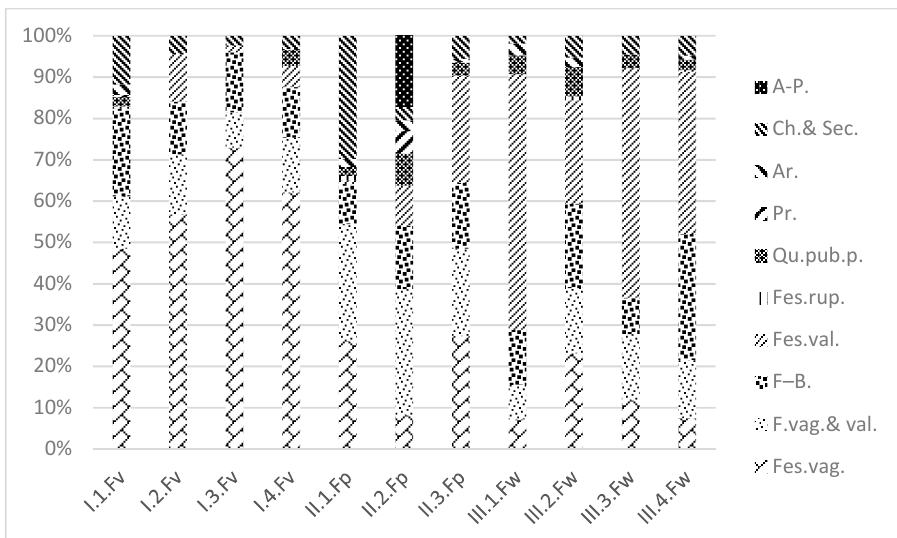
Figure 2. Coenosystematic composition of the grassland types under investigation. ( Festuca vaginata vegetation types: I.1.Fv: Little Hungarian Plain, I.2.Fv: northern part of Kiskuns á g, I.3.Fv: southern part of Kiskuns á g, I.4.Fv southernmost part. Festuca pseudovaginata II.1.Fp: degraded type dominated by weeds, II.2.Fp: woody patches, II.3.Fp: natural